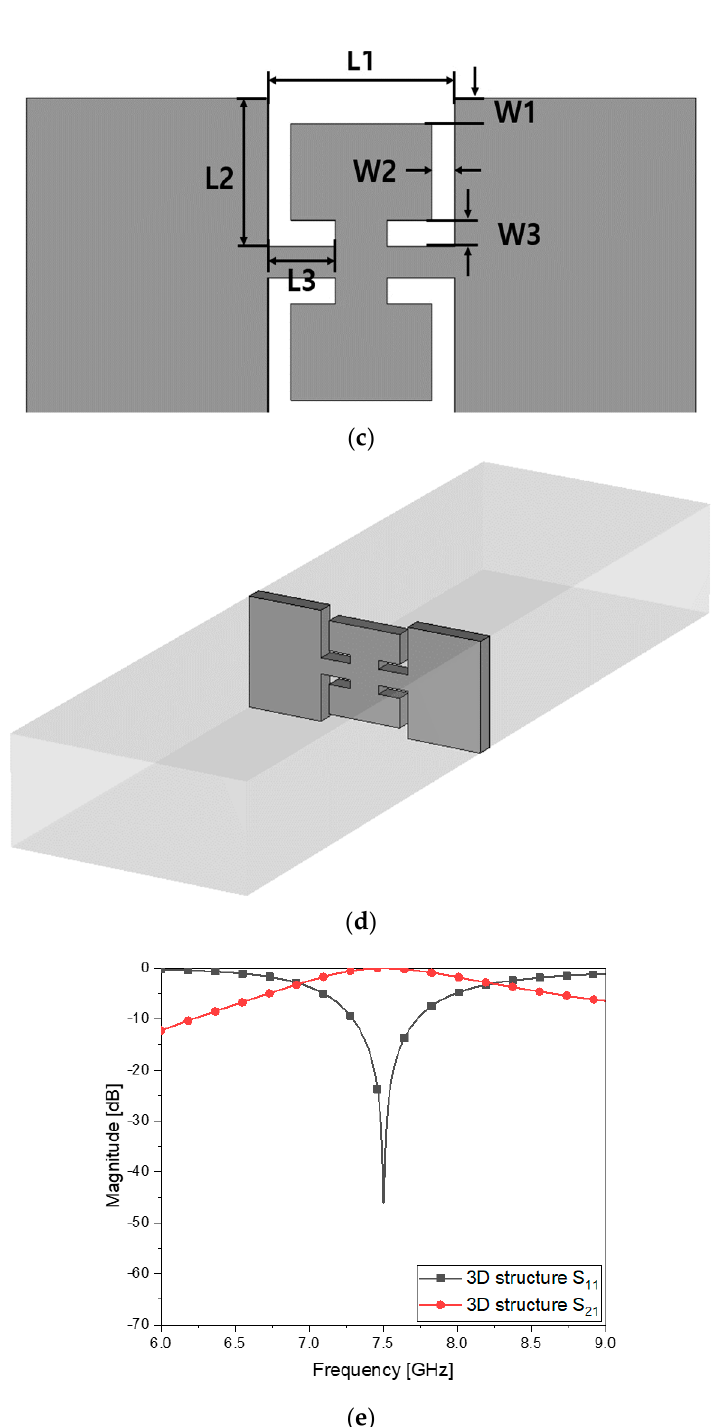
Figure 3. Circuit model of the CRLH resonator and move into the waveguide. ( a ) E − CRLH circuit of the resonator applied to the waveguide cross − section. ( b ) S 11 and S 21 of the resonator circuit. ( c ) Physical shape of the thin resonator. ( d ) The resonator is longitudinally flat. ( e ) S 11 and S 21 of the resonator structure. Table 3. The values of the circuit elements of the E − CRLH resonator.